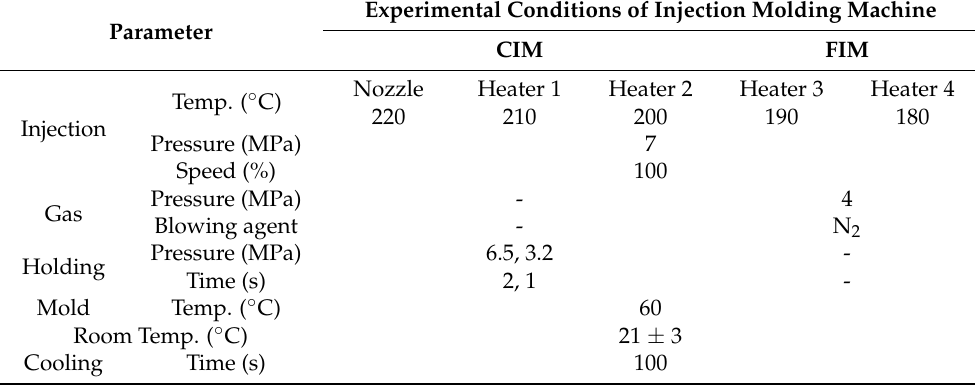
Table 2. Conditional parameters for CIM and FIM.